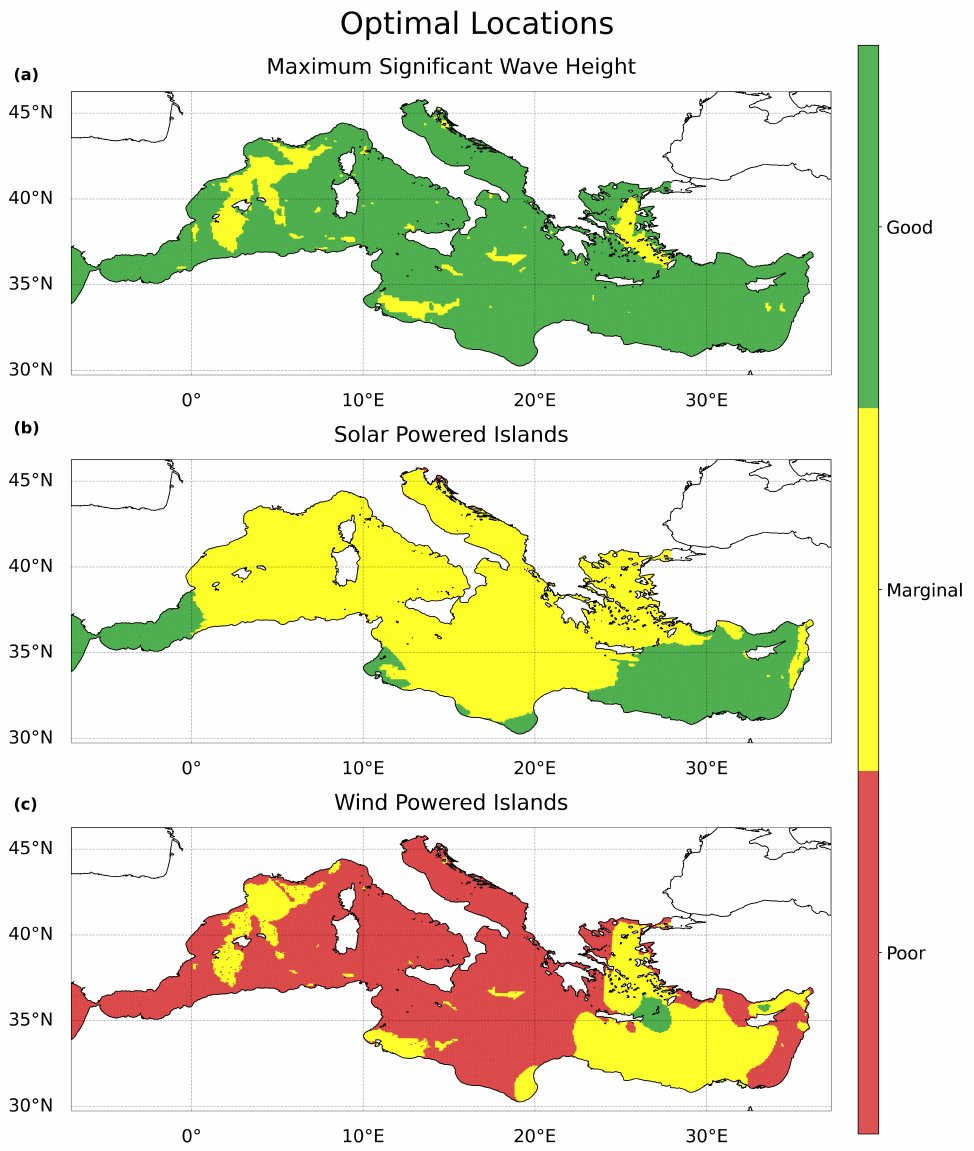
Figure 21. Optimal locations for solar or wind powered methanol producing islands. Subplot ( a ) shows the poor (none shown), marginal, and good locations according to the maximum significant wave heights (poor: above 1.5 m, marginal: between 1 and 1.5 m, good: below 1 m). ( b ) shows the combined above maximum significant wave height and solar powered methanol production of optimal locations (poor: below 400 mL m − 2 integrated methanol production over a year, marginal: between 400 and 470 mL m − 2 , good: above 470 mL m − 2 ). ( c ) is the same as ( b ) but for wind powered islands (poor: below 140 mL m − 2 , marginal: between 140 and 350 mL m − 2 , good: above 350 mL m − 2